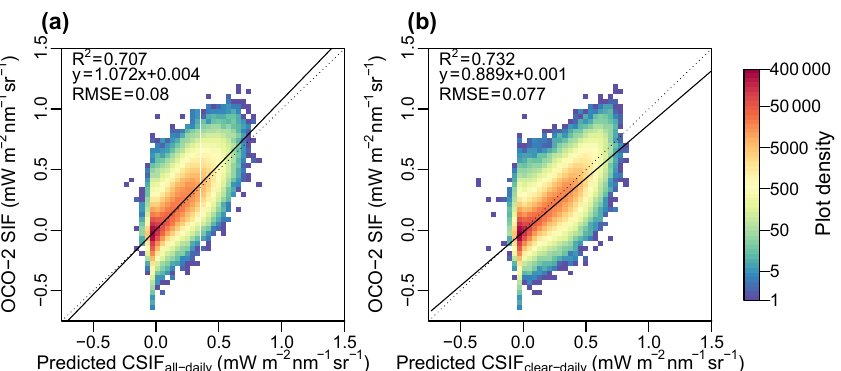
Figure 5. Comparison between the retrieved SIF and the (a) predicted all-sky daily CSIF and (b) clear-sky daily CSIF. The instantaneous SIF retrievals from OCO-2 were converted to daily average values for